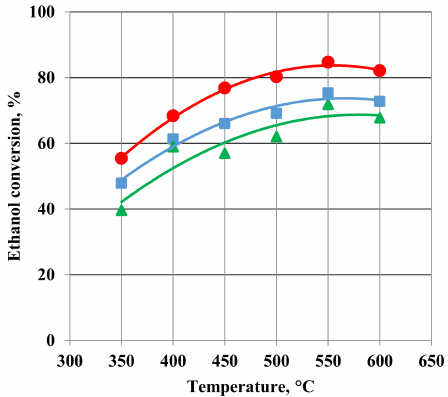
Figure 5. The influence of temperature and feed flow rate on ethanol conversion. Water to ethanol